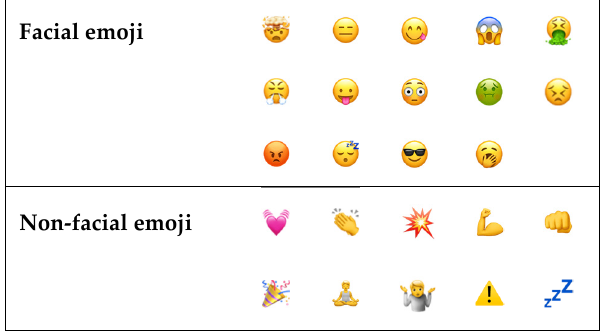
Figure 1. Emoji included in the research. Table 1. The 18 semantic differentials in the pleasure-arousal-dominance (PAD) scale used in Study 1 and Study 2, with end-point anchors